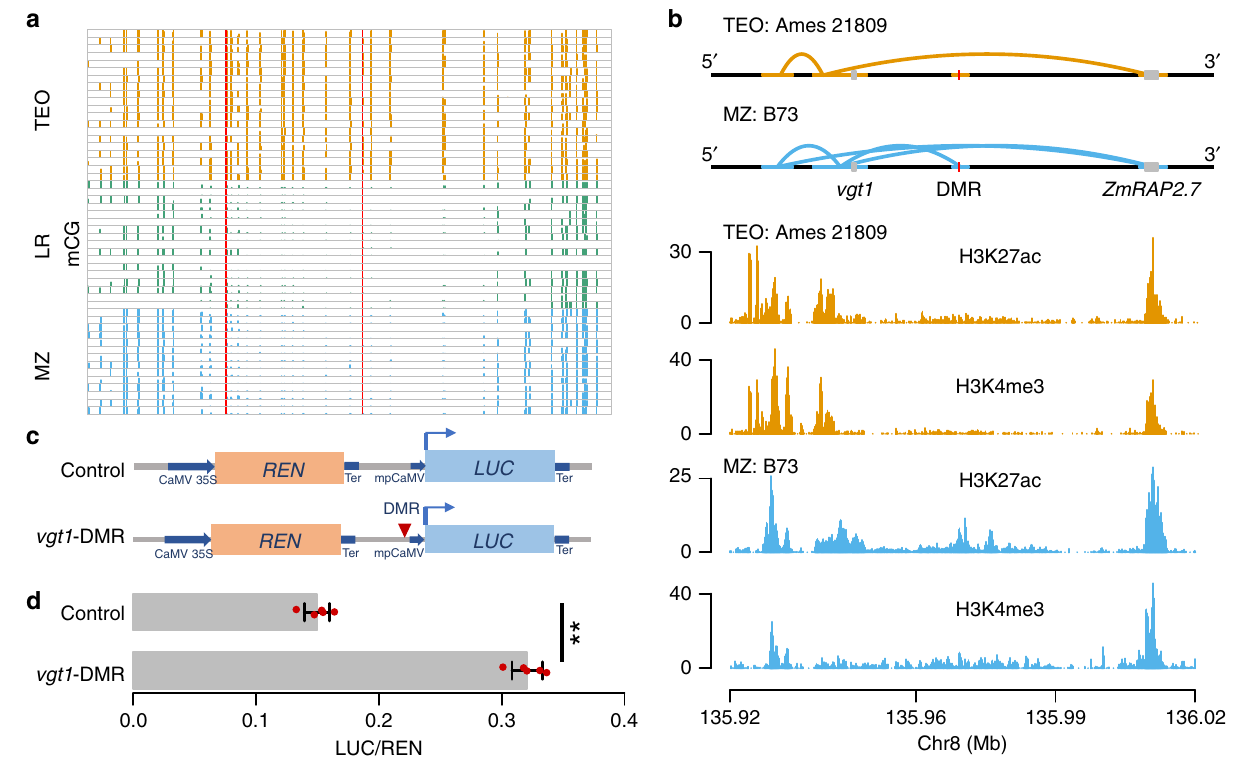
Fig. 4 Functional analysis of vgt1 -DMR. a Levels of CG methylation around vgt1 -DMR in maize (MZ), landrace (LR), and teosinte (TEO) populations. Vertical red lines indicate the boundaries of the vgt1 -DMR. b The interactive contacts (upper panel) and colocalization with H3K27ac and H3K4me3 (lower panel) around vgt1 -DMR in a maize (B73) and a teosinte (Ames 21809) samples. c The vectors constructed for functional validation of the vgt1 -DMR using the dual-luciferase transient expression assay in maize protoplasts. d The expression ratios of LUC/REN using fi ve biological replicates. Error bars indicated SDs. Statistical signi fi cance was determined by a two-sided t -test (** P -value = 3.6 × 10 − 8 ). Source data underlying a , d are provided as a Source Data fi